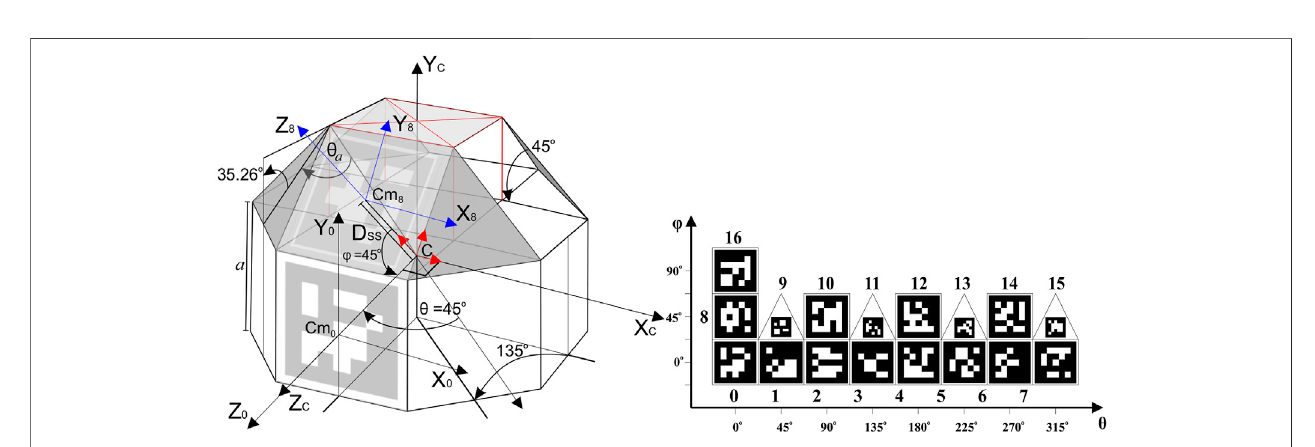
FIGURE 2 | Truncated rhombicuboctahedron geometry and fi ducial marker